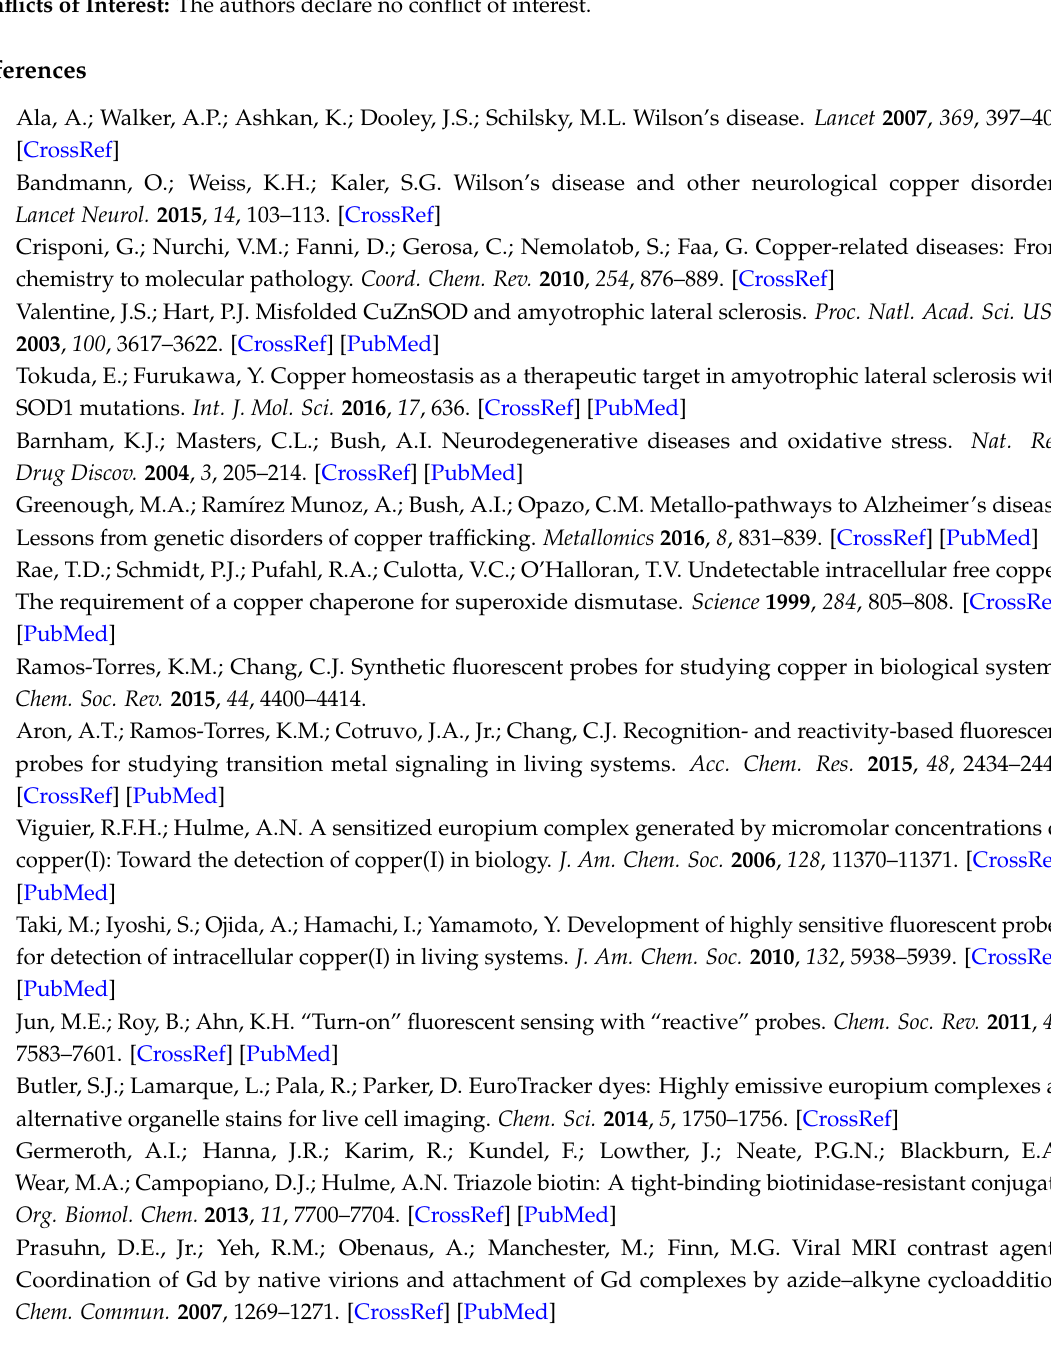
20-Tb ; Figure S2: HPLC chromatogram of crude reaction product 19-Tb ; Tables S5 and S6: normalized IR spectra for complexes 18 and 19 ; 1 H and 13 C-NMR spectra for azides 7 , 8 and 9 ; HPLC chromatogram, UV-vis, MS and 1 H-NMR spectra for purified complex 19-Eu